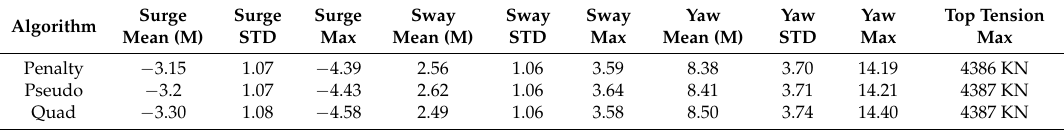
Table 11 . Mean Value and Standard Deviation by Three Different Thrust-Allocation Algorithms.